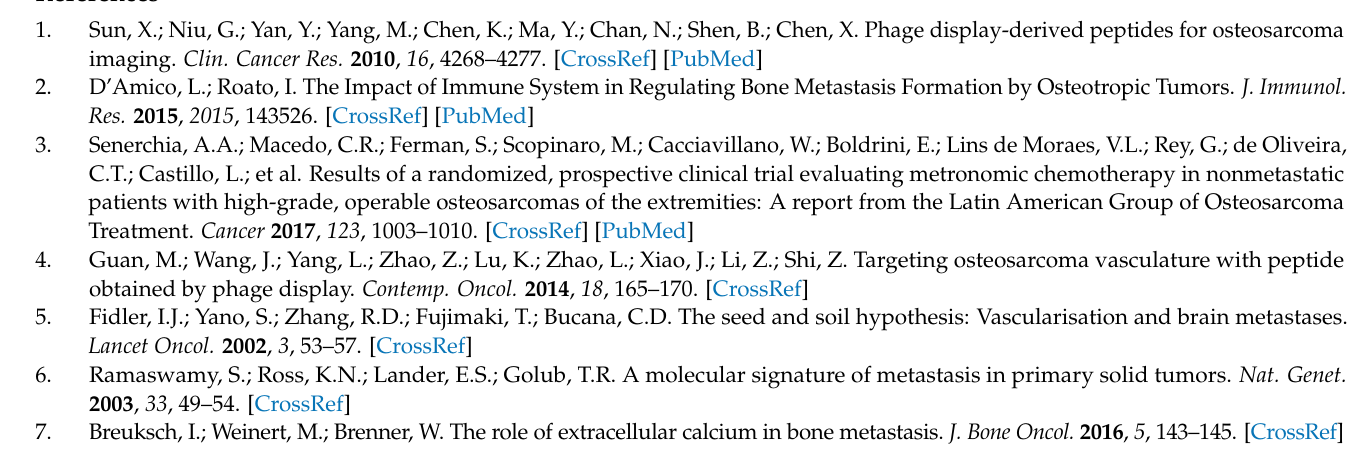
Table S1: Phage Library Screening for